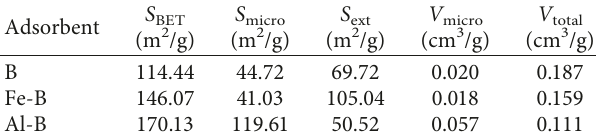
Table 1: Textural parameters of B, Fe-B, and Al-B